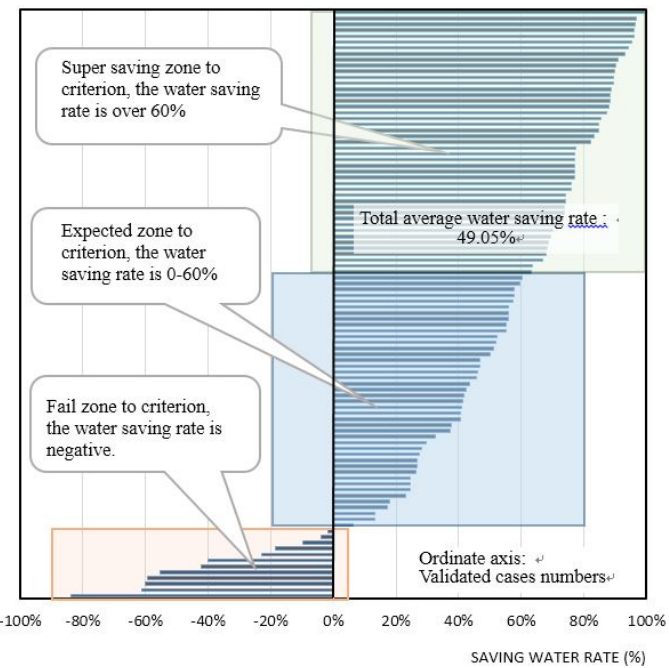
Figure 1. Distribution of water-saving rates for validated cases.